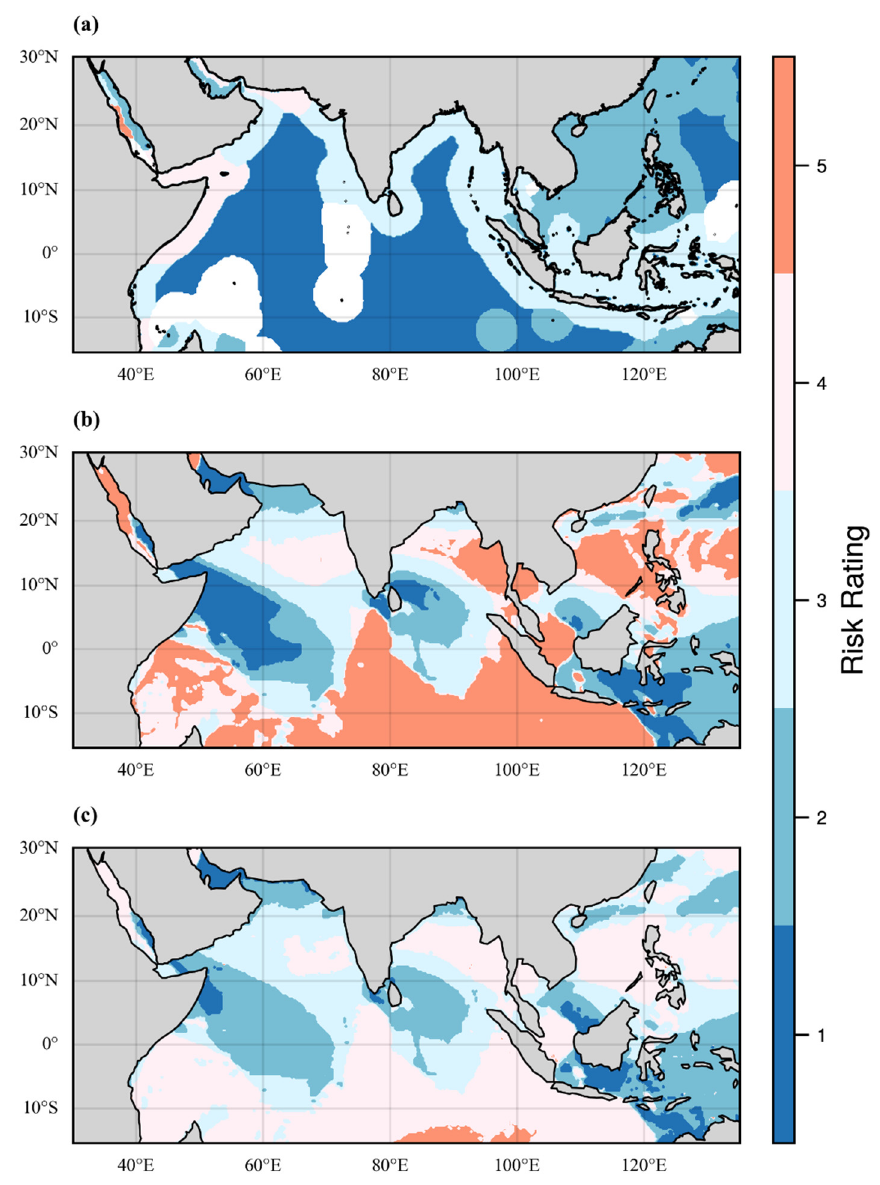
Figure 6. Results of different indicator systems in 2020: ( a ) only geo-human influences; ( b ) only wind-energy resources; ( c ) comprehensive risk.